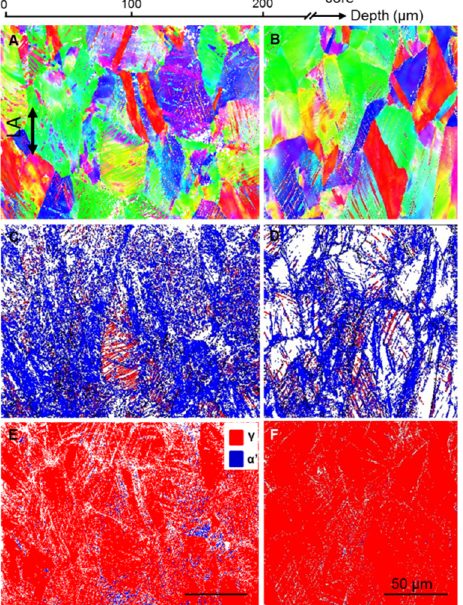
Figure 4. Cross-sectional EBSD images of deformation features in the GDS 304 SS samples at a tensile strain of 40%, showing the distributions of grain-scaled morphology ( A ), LABs ( A ) and phase ( E ) within an approximately 0.2 mm depth from the surface, compared with that in the core ( B , D , F ).